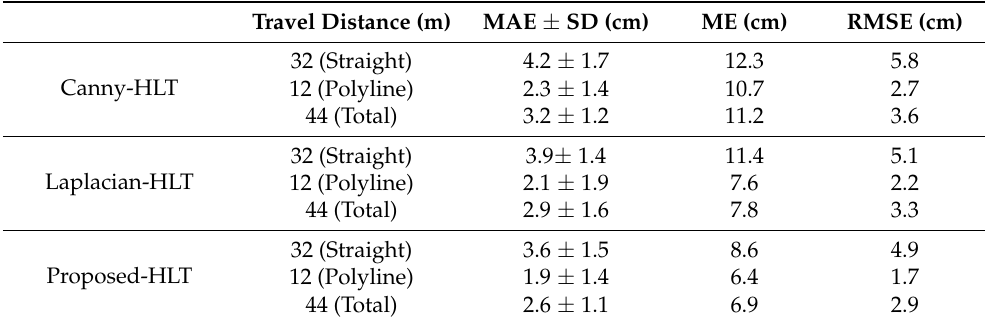
Table 2. The performance evaluation results of different line detection methods in the guidance system of the robot.